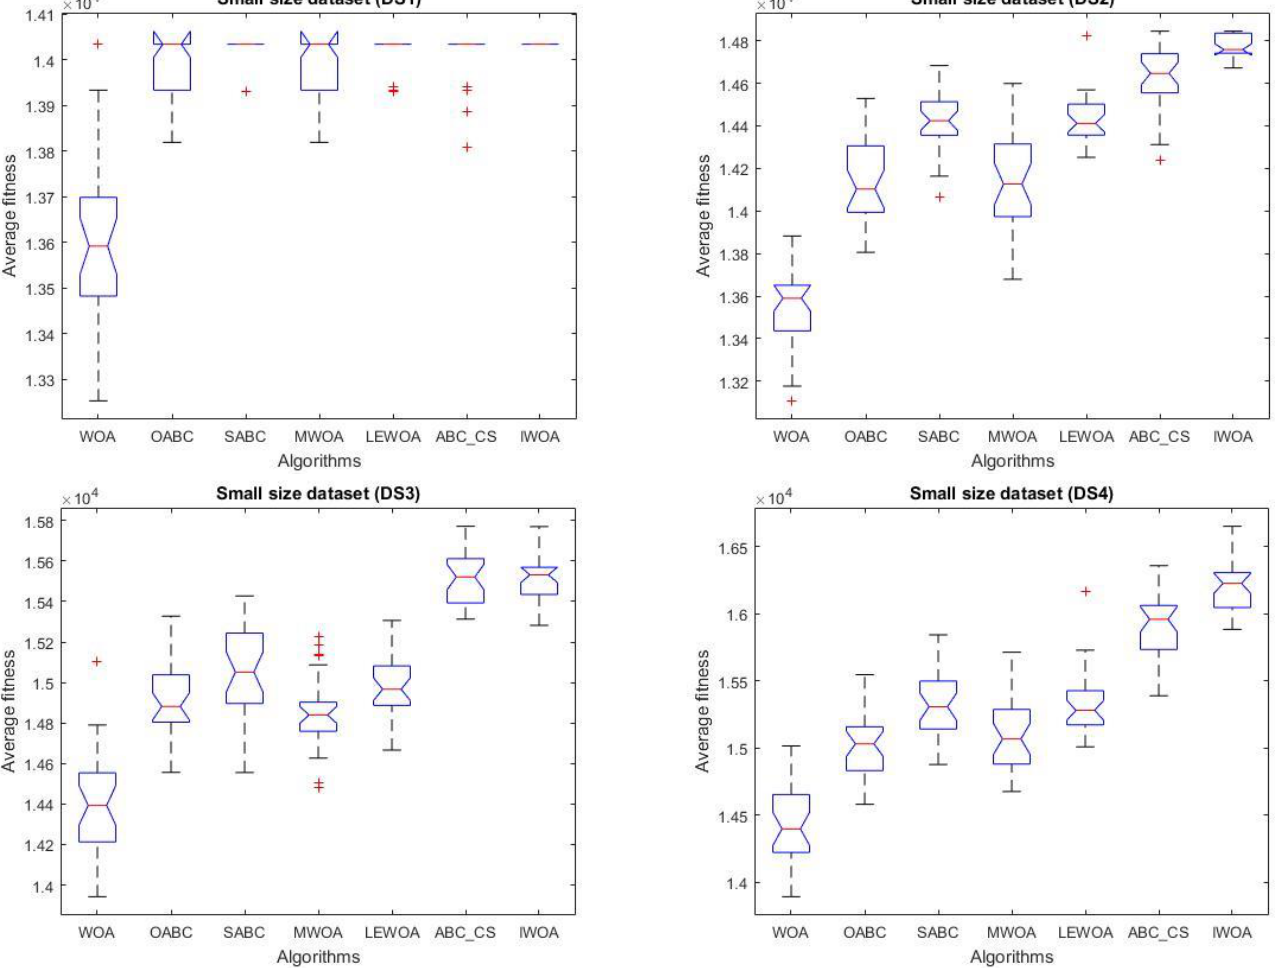
Figure 2. Boxplots for the average fitness value obtained using the compared algorithms for the small-sized datasets.